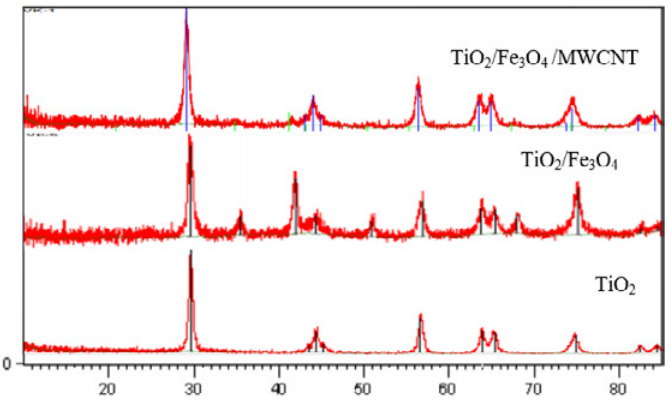
Fig. 7. XRD spectra of TiO 2 , TiO 2 /Fe 3 O 4 and TiO 2 /Fe 3 O 4 / MWCNT